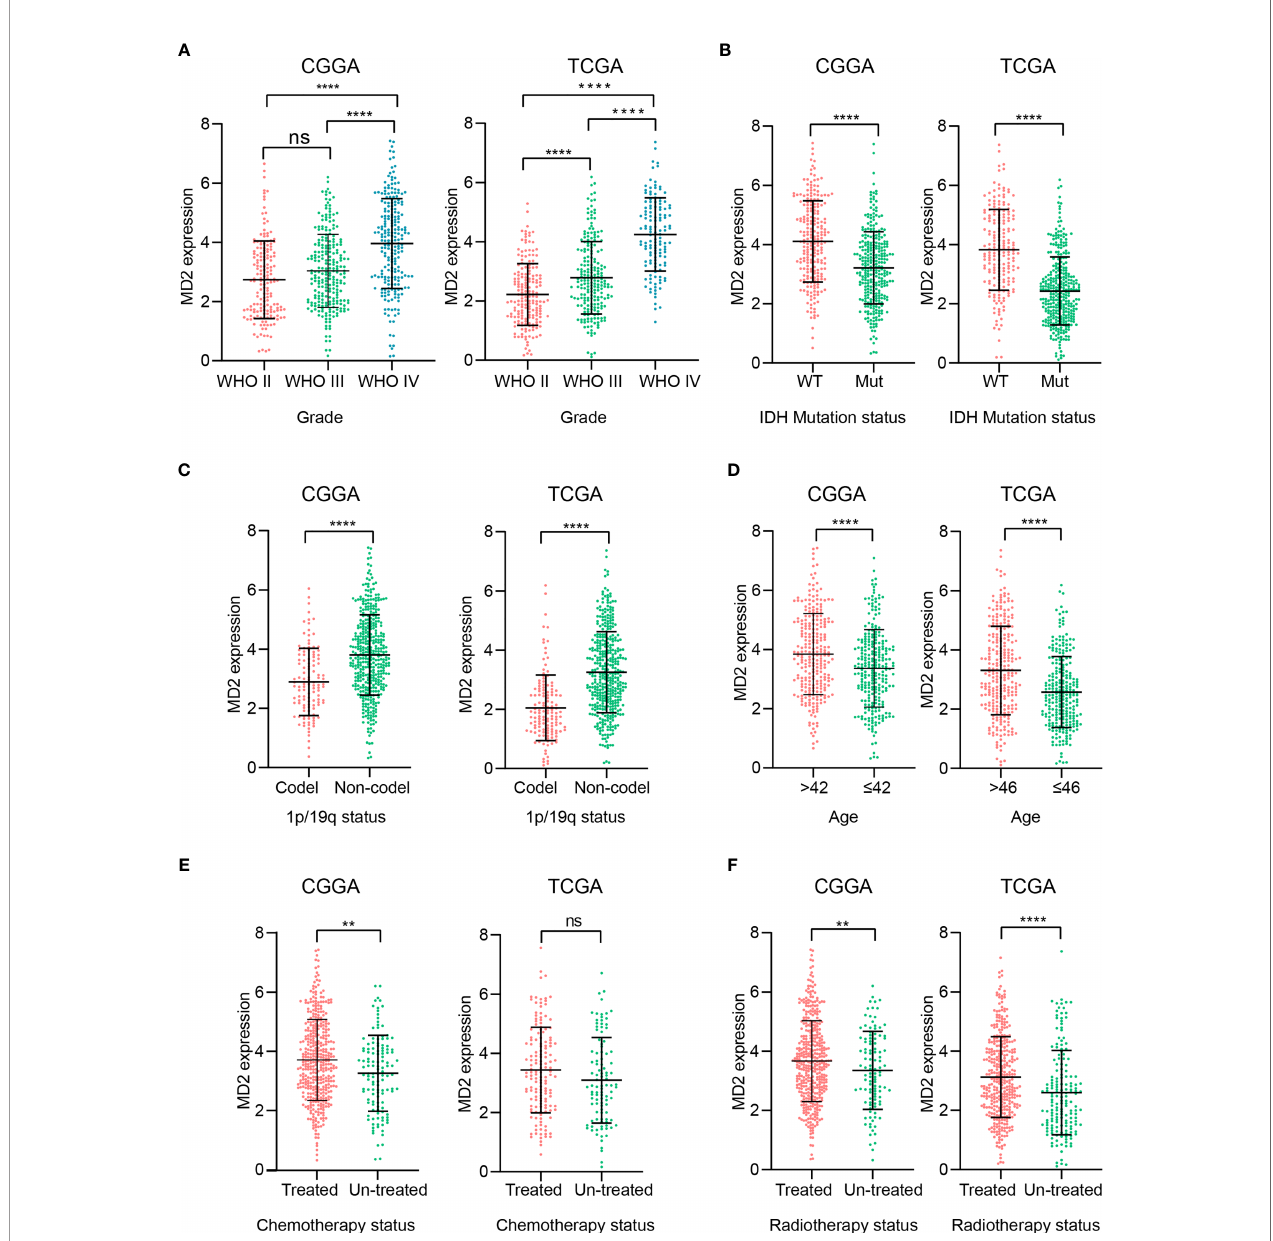
FIGURE 2 | The association between MD2 expression and clinicopathologic characteristics. (A) The correlation analysis between MD2 expression level and WHO grade in CGGA and TCGA datasets. (B) The relationship analysis between MD2 expression level and IDH1 status in CGGA and TCGA datasets. (C) The association analysis between MD2 expression level and 1p/19q status in CGGA and TCGA datasets. (D) The correlation analysis between MD2 expression level and glioma patients ’ age in CGGA and TCGA datasets. (E) The association analysis between MD2 expression level and chemotherapy in CGGA and TCGA datasets. (F) The relationship analysis between MD2 expression level and radiotherapy in CGGA and TCGA datasets. WT, Wildtype; Mut, Mutant. ** and **** indicate p < 0.01 and p < 0.0001, respectively; ns, not statistically signi fi